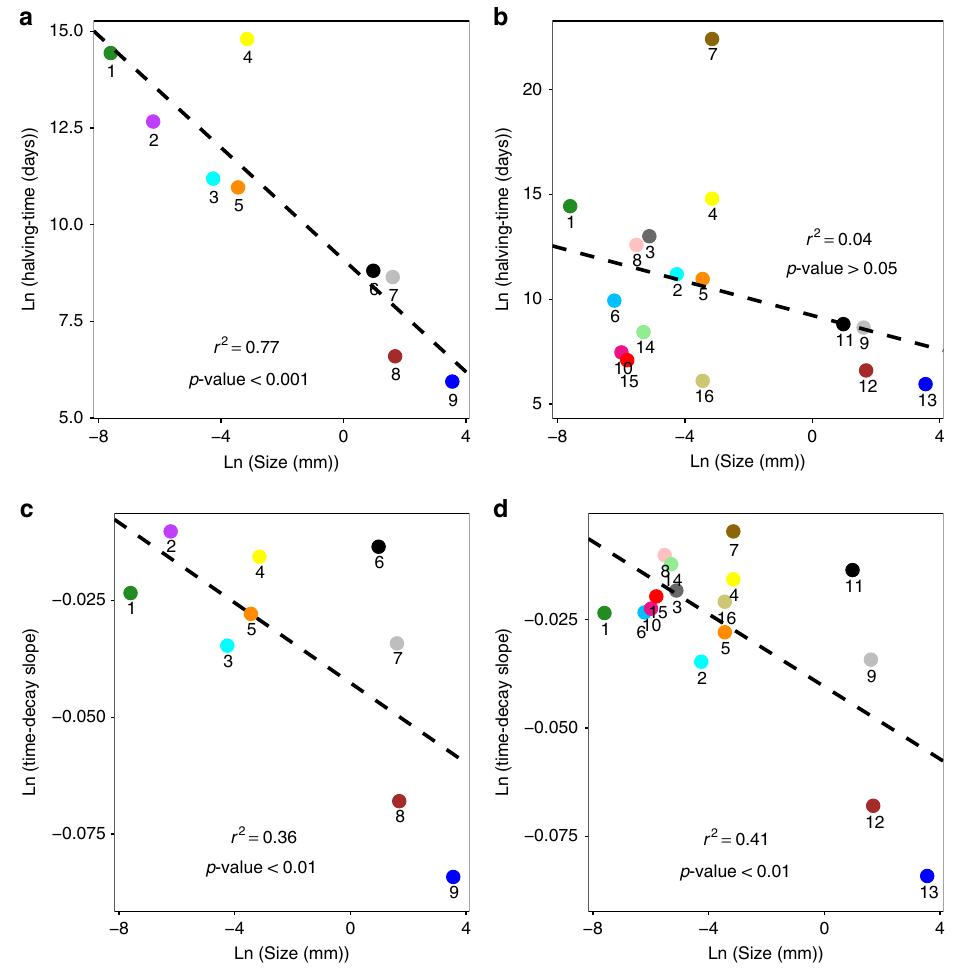
Fig. 2 Correlations between halving-time and time-decay slope with body size and local abundance. a Correlation between the logarithms of halving-time ( y ) and body size ( x ) in main biological groups; linear regression equation y = 9.093 – 0.724 x , n = 9, r 2 = 0.767, p -value < 0.001. b Correlation between the logarithms of halving-time ( y ) and body size ( x ) in all biological groups; linear regression equation y = 9.223 – 0.406 x , n = 16, r 2 = 0.037, p -value > 0.05. c Correlation between the logarithms of the time-decay slope ( y ) and body size ( x ) in main biological groups; linear regression equation y = − 0.042 − 0.004 x , n = 9, r 2 = 0.363, p -value < 0.01. d Correlation between the logarithm of the time-decay slope ( y ) and body size ( x ) in all biological groups;